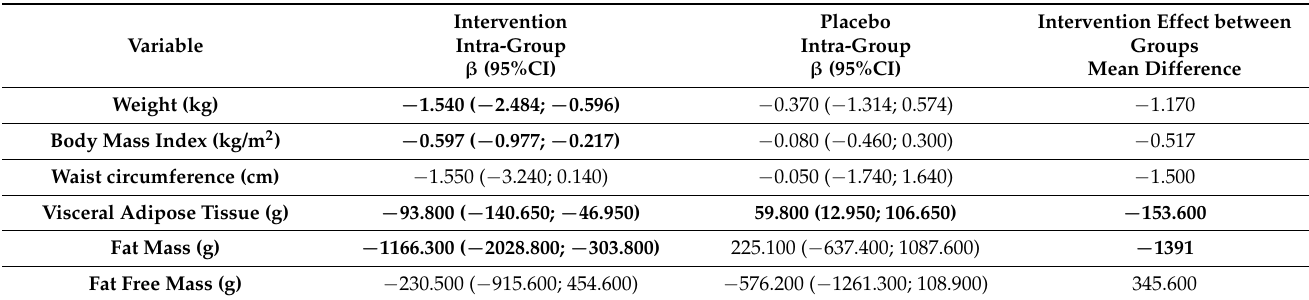
the null hypothesis of a null effect are